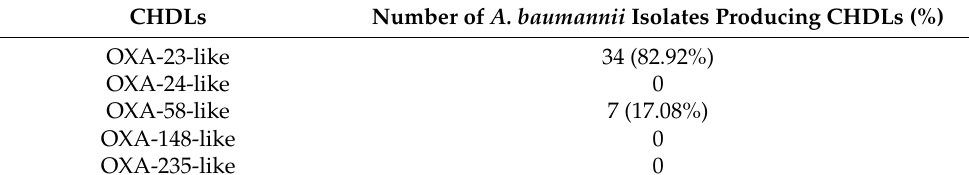
Table 3. Identification of CHDLs between 41 CHDLs-producing A. baumannii.